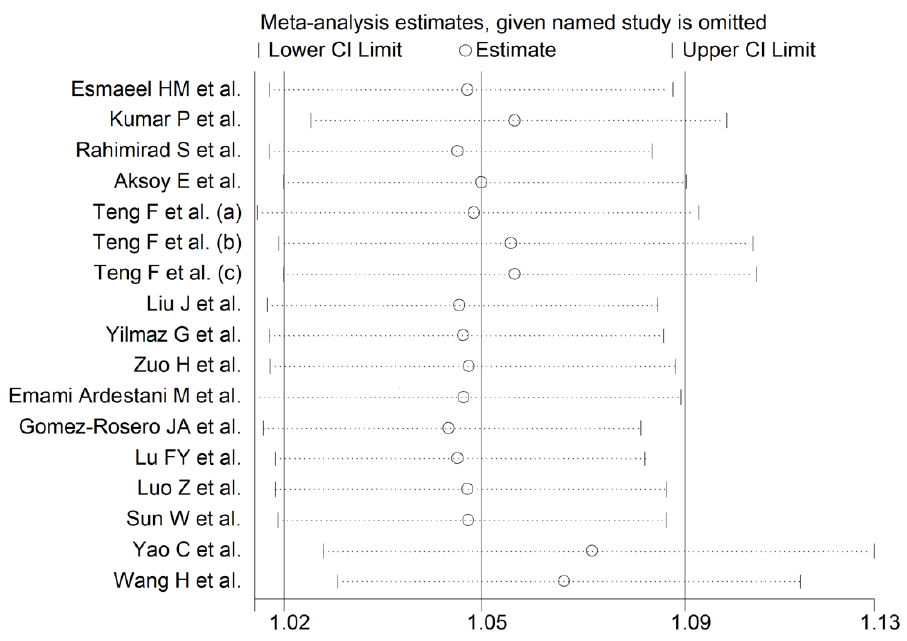
Figure 2. Forest plot of the association (odds ratio) between the neutrophil-to-lymphocyte ratio and adverse outcomes in AECOPD patients. p = 0.000 indicates a p -value < 0.001.